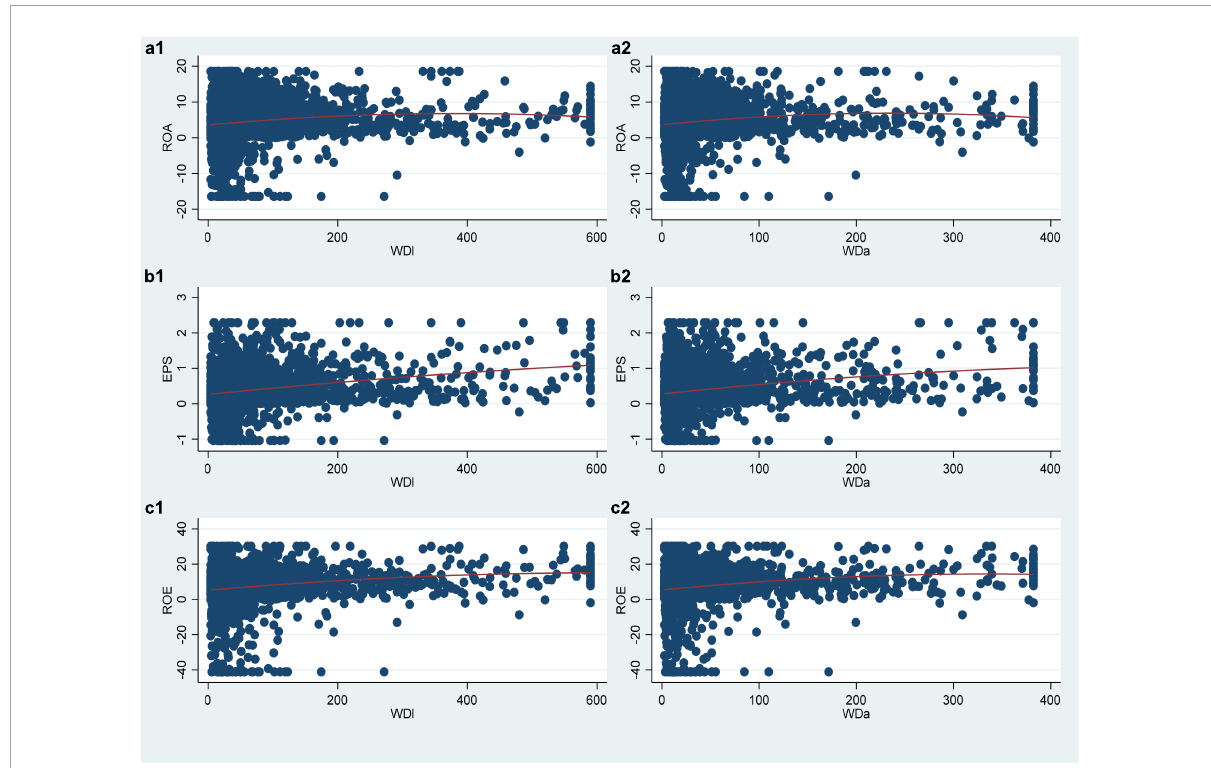
FIGURE1 Sample scatter plot. (a1–c2) Represent the relationship between different variables.